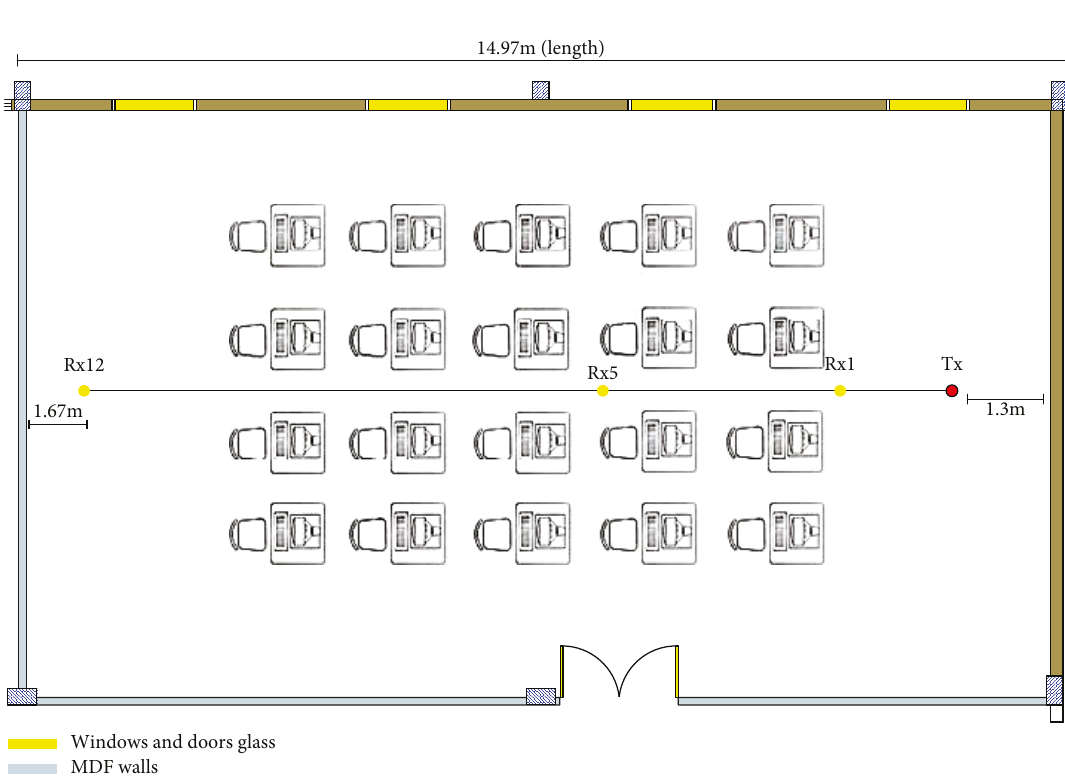
Figure 1: Distance for Tx as done.